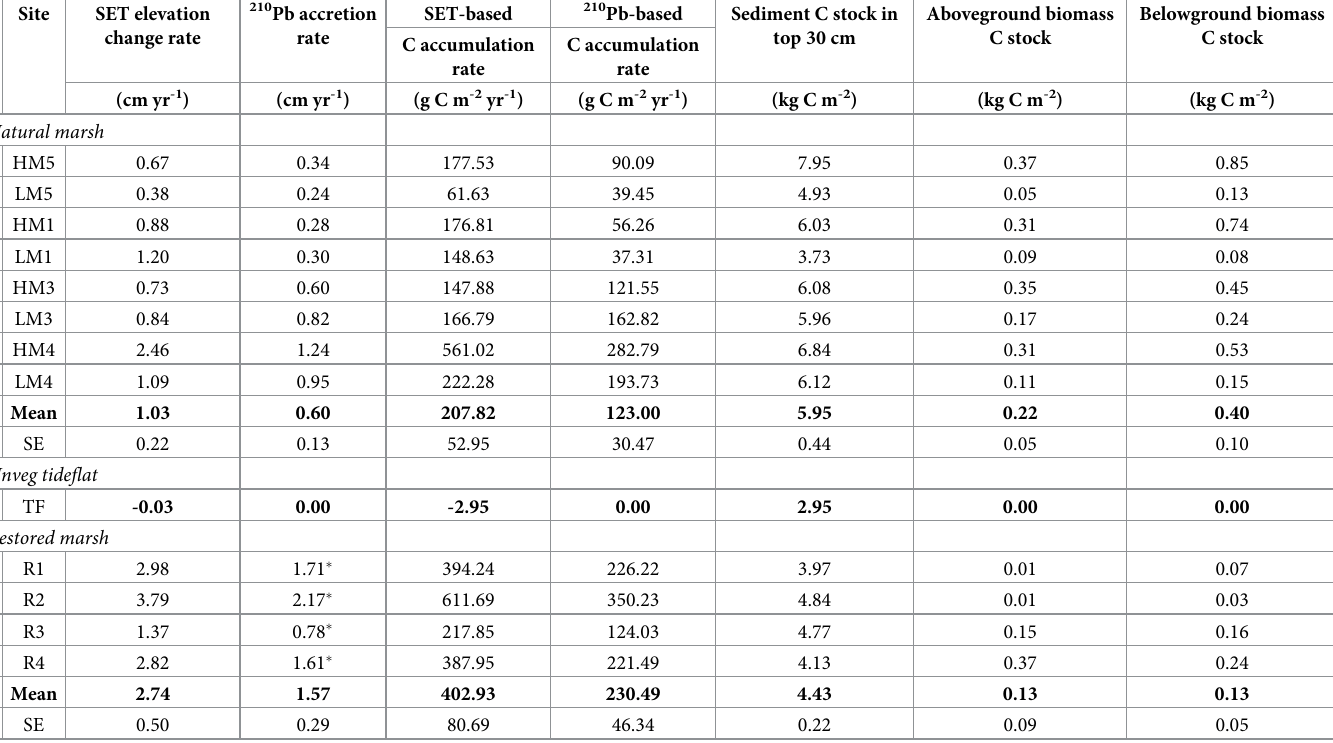
Table 2. Rates of elevation change, accretion, and carbon accumulation, and carbon stocks across the three carbon pools. SET elevation change rates represent a 4–7 year time period of record, while 210 Pb accretion rates represent an approximately 100-year record. Both C accumulation rates incorporate the 30-cm average soil carbon